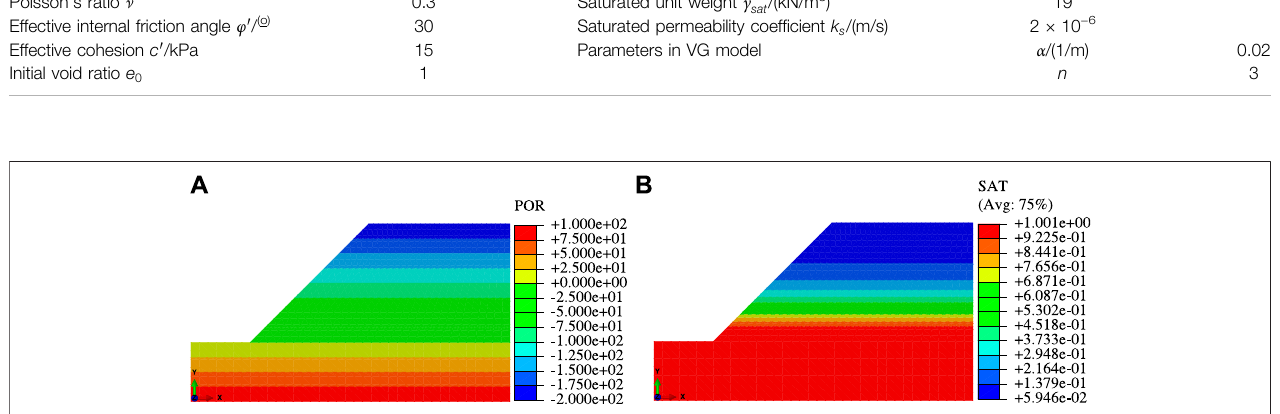
FIGURE 12 | Nephogram of pore pressure and effective degree of saturation at the initial state: (A) Pore pressure and (B) effective degree of saturation.